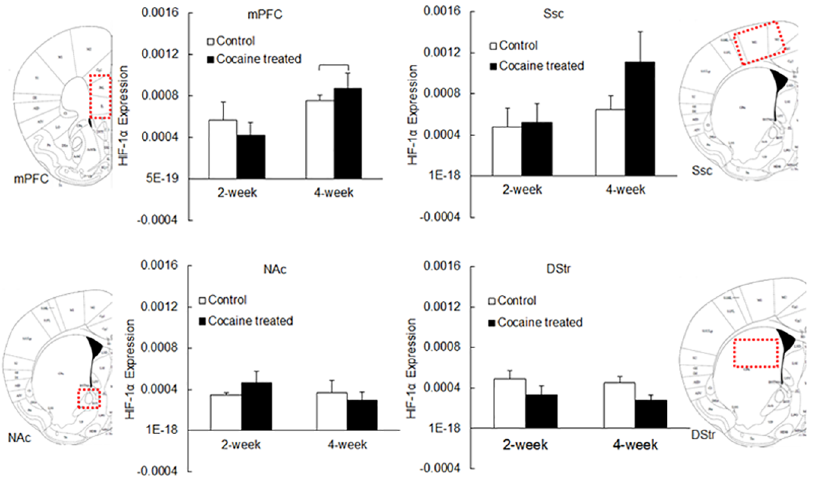
Fig 7. HIF-1 α expression in rat brain tissue measuredusing Western blot. Data is presentedas mean + standard error (n = 3–9). ANOVA was used to detect significantdifference betweentreatment groups. Significant differences( P < 0.05)are